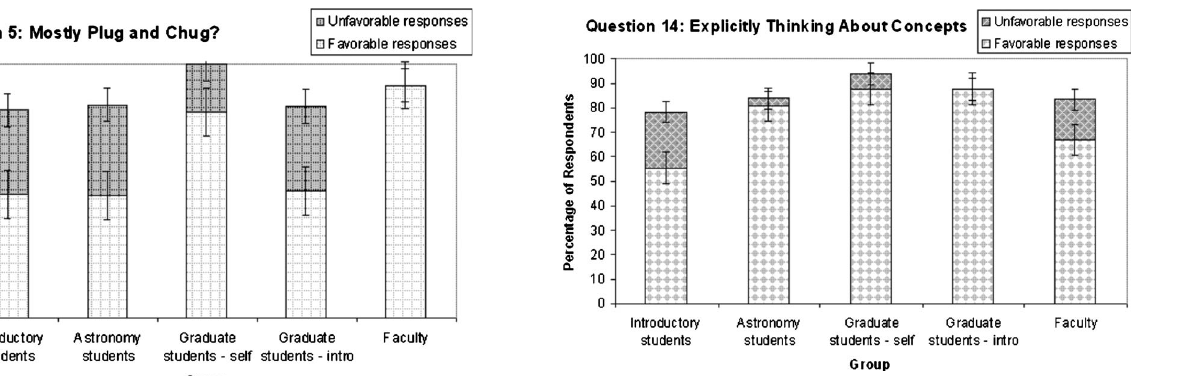
FIG. 4. Histogram showing favorable (cid:1) disagree (cid:2) and unfavor- able (cid:1) agree (cid:2) responses for survey question (cid:1) 5 (cid:2) about whether prob- lem solving in physics is mainly an exercise in finding the right formula. The histogram shows that a large percentage of nonfaculty respondents from all groups agreed with the statement or were neutral.